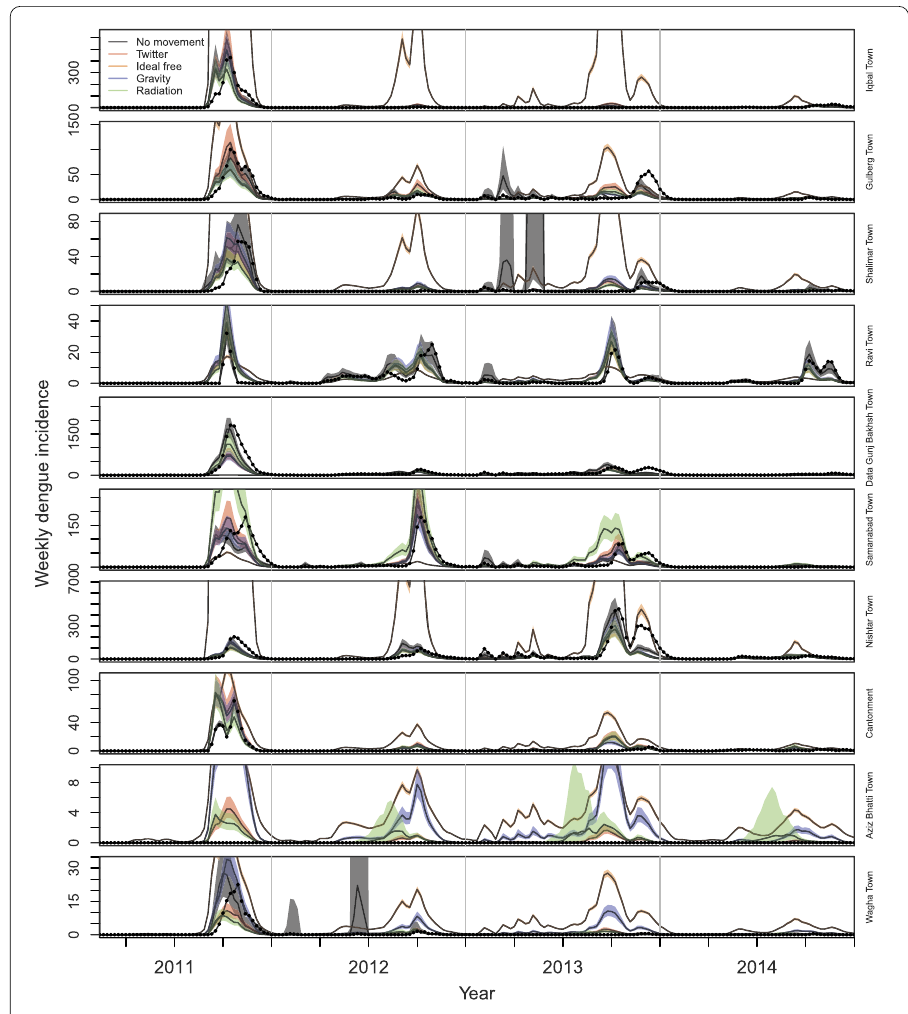
Figure 5 Predicted values of residence-based incidence in each town (rows) using the best-fit model under each of five different assumptions about mobility (colors). Observed values of residence-based incidence in each town are shown with black dots, and bands show 95% confidence intervals on model